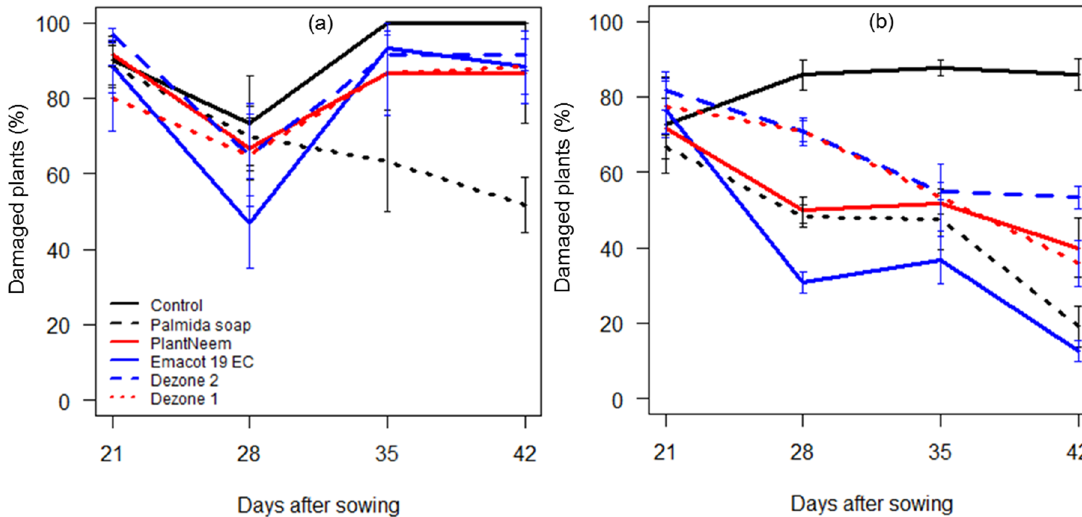
Figure 3. Percentage of plants with Spodoptera frugiperda damage based on weekly observations of 15 maize plants per plot at Adjohoun ( a ) and 30 plants at N’Dali ( b ) on each collection date. The treatments included Palmida soap, PlantNeem, Emacot 19 EC, Dezone, and the untreated control. Dezone 1 and 2 refer to application rates of 7.5 and 15 kg/ha, respectively.